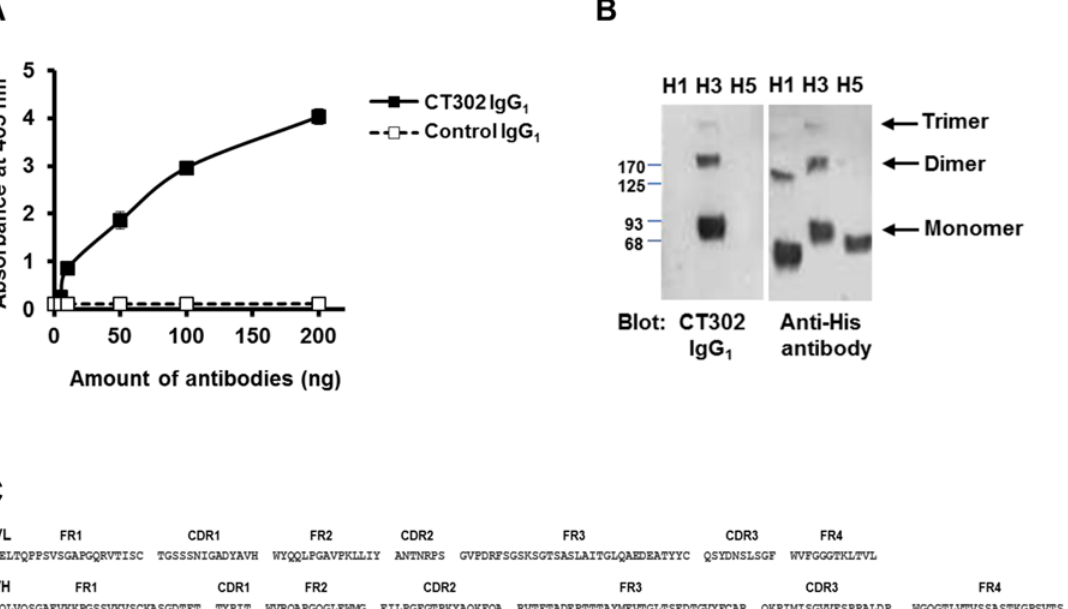
Fig 1. Reactivity of CT302 IgG 1 to H3N2 trimeric HA. (A) After recombinant trimeric HA protein was coated onto 96-well plates, CT302 IgG 1 ( & ) or negative-control anti-respiratory syncytial virus IgG 1 ( & ) was incubated in wells as primary detection antibodies. Antibody bound to the recombinant His- tagged trimeric HA protein was detected with an HRP-conjugated anti-human IgG by addition of HRP substrate. Results represent the mean ± S.D. obtained from duplicate wells per each condition. (B) Recombinant His-tagged trimeric HA proteins from H1, H3, and H5 strains were resolved by SDS-PAGE and transferred to nitrocellulose membranes, which were probed with CT302 IgG 1 or anti-His antibody. (C) Amino acid sequences in the V H and V L regions of CT302 IgG 1 . HA, hemagglutinin; HRP, horseradish peroxidase.